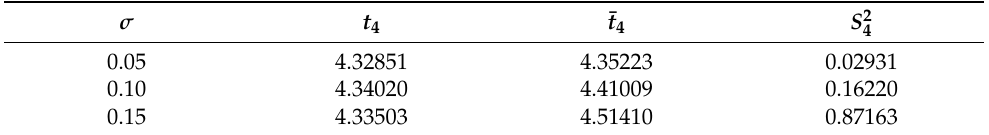
Table 1. t 4 , ¯ t 4 , and S 2 values corresponding to the time instants at which the mean of the sample 4 paths and the sample paths reach a value of 4 for the first time.